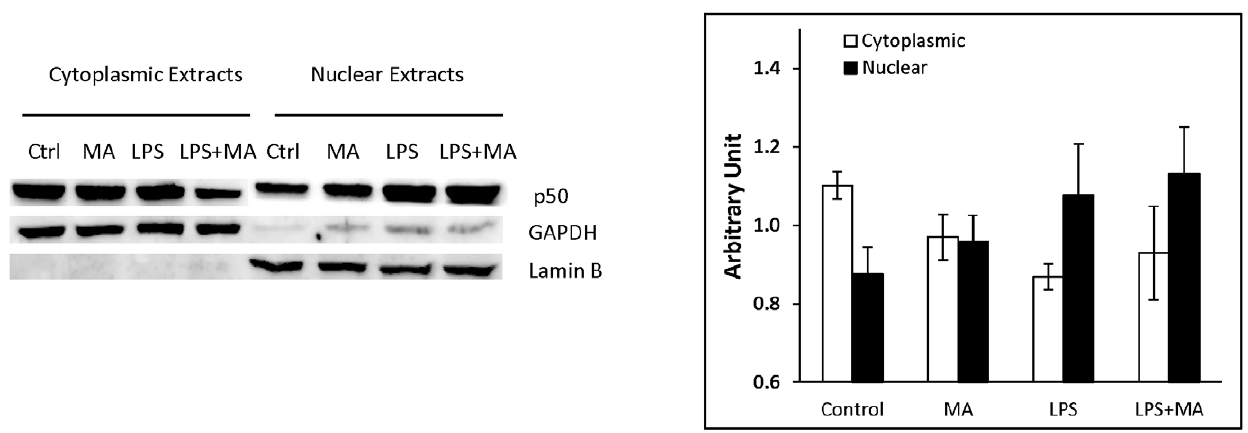
Figure 2. Treatment of U937 macrophages with MA ± LPS resulted in increased translocation of the p50 subunit of NF- k B. 1 6 10 6 U937 monocytes were differentiated into macrophages with 100 nM PMA for 48 h. Cells were treated with MA at 0, 24 and 48 h then stimulated with 100 ng/ml LPS for 3 h. Cytosolic and nuclear protein fractions were purified by electrophoresis on 10% SDS gel and transfer to a PVDF membrane. The cytosolic fractions and nuclear fractions are shown in a representative western blot. The expression of the p50 subunit was normalized to the appropriate compartmental housekeeping genes (Lamin B for nucleus and GAPDH for cytoplasm). The means and SE values are from three independent